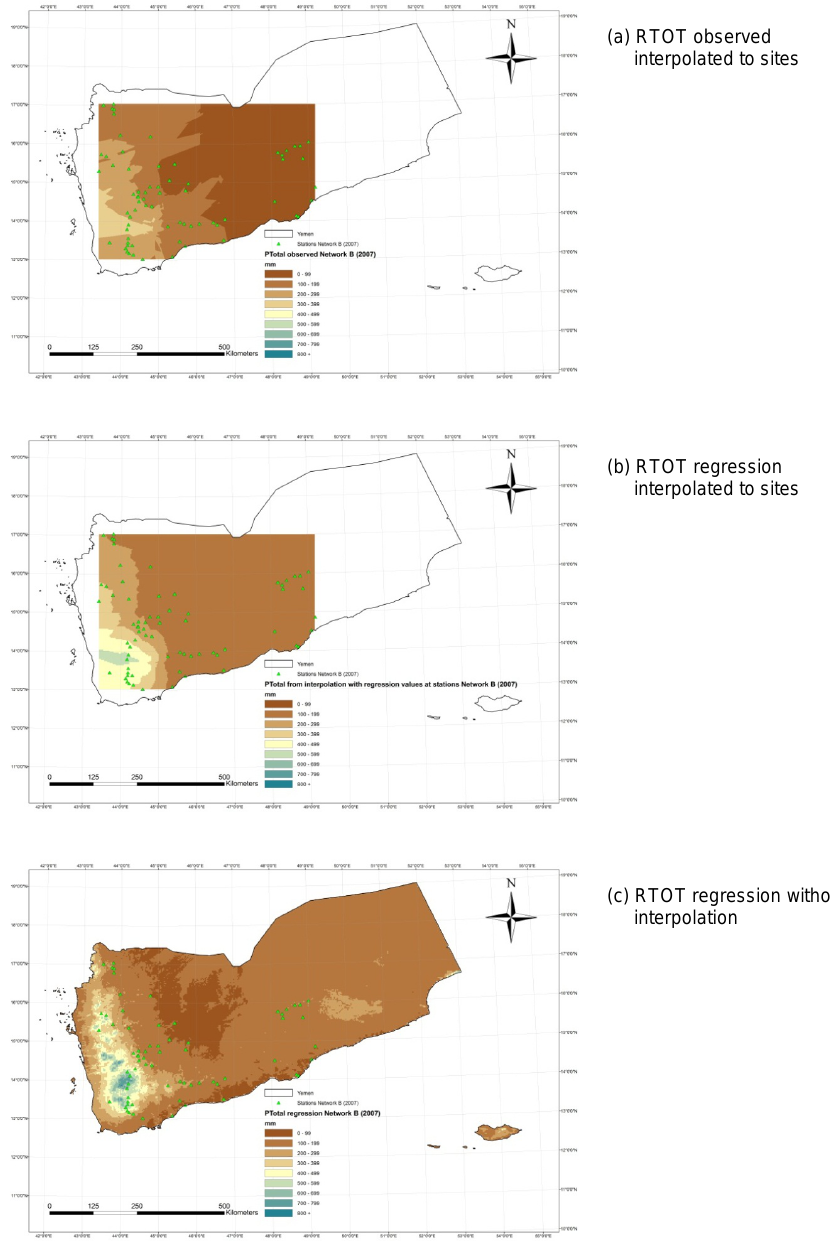
Fig. 12. As in Fig. 11 but for Network